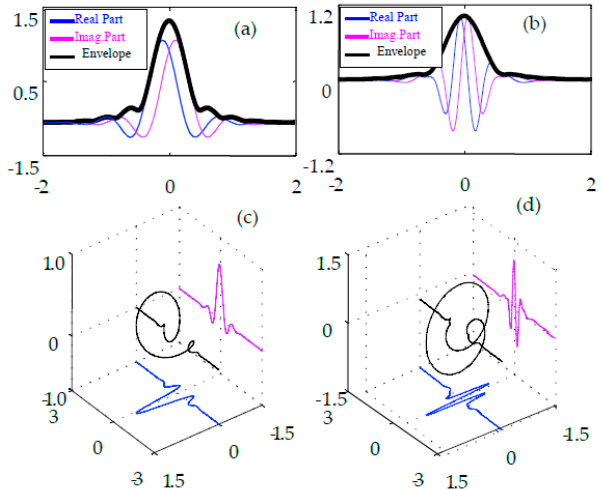
Figure 5. ( a ) Envelope of the complex scaling functions; ( b ) envelope of the complex wavelet functions; ( c ) 3D plot of the complex wavelet functions; and ( d ) 3D plot of the complex wavelet functions.